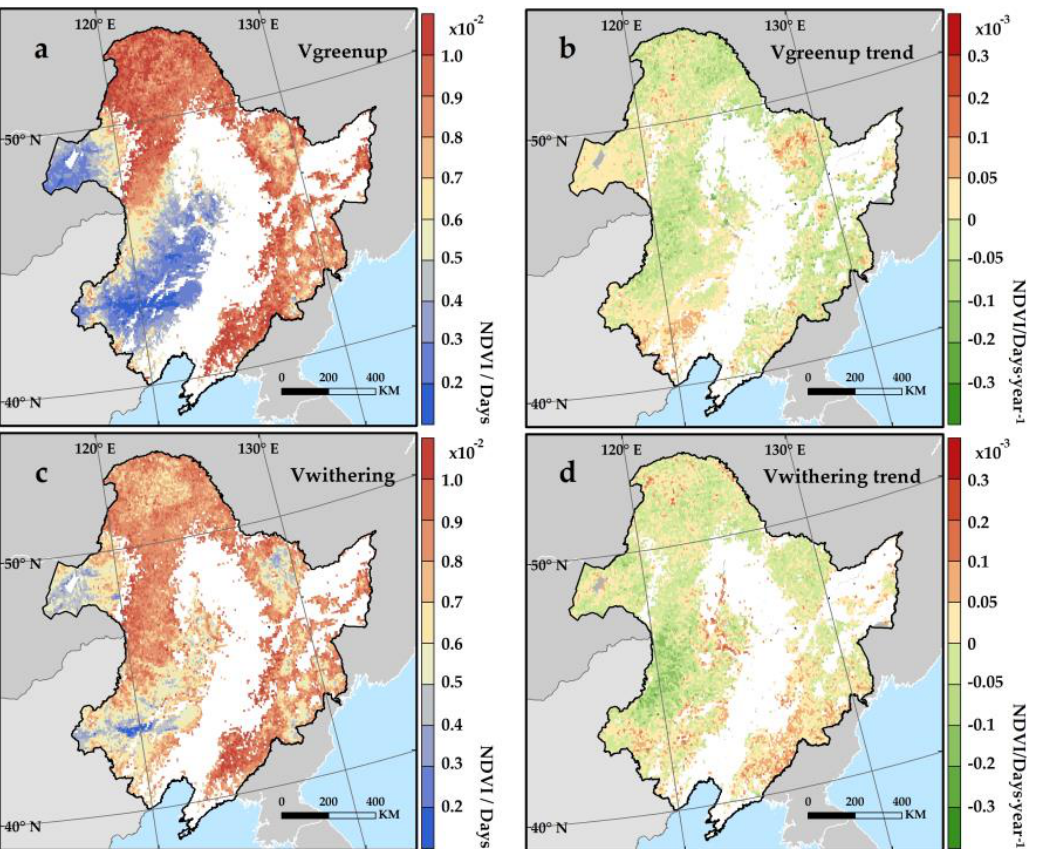
Figure 5. Spatial patterns of velocity of vegetation greenup, withering and their trends in Northeast China from 1982 to 2015: ( a ) mean velocity of vegetation greenup (Vgreenup); ( b ) trends in Vgreenup; ( c ) mean velocity of vegetation withering (Vwithering); ( d ) trends of the Vwithering. The spatial patterns for Vwithering in Northeast China were consistent with Vgreenup. It was observed that the Vwithering value was greater than Vgreenup, with an average value of 0.82 × − 2 / − 2 10 day (SD: 0.16 × 10 , Figure 5c). High Vwithering occurred in the north and middle part of the Greater Khingan Mountain and the southern Changbai Mountain where the main land cover type was forests, while Vwithering was lowest in grasslands such as the western Liaohe Plain and western Hulun Buir. Over half (52.24%) of the pixels in Vwithering had a negative trend (Figure 5d) and were mainly distributed in the southern Greater Khingan Mountain steppe region, but only 9.93% of the pixels had statistical significance ( p < 0.05, Figure S4b). The pixels with a positive trend were mainly distributed in the southern part of the Changbai Mountains and western Liaohe River